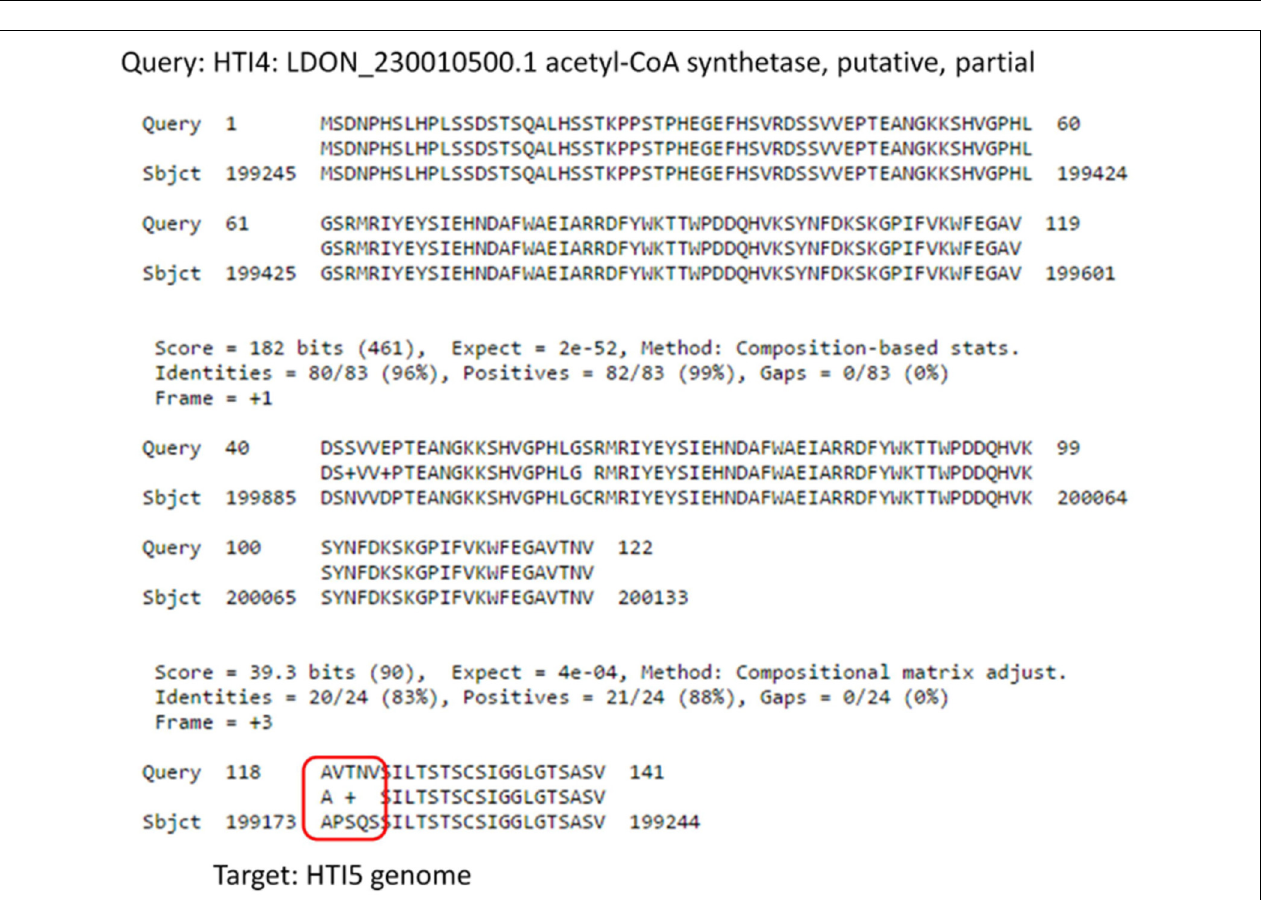
FIGURE 7 | Comparison of Acetyl Co-A synthetase genes in early and late passage. Gene coding for Acetyl CoA Synthetase undergoes several substitutions in the late passage which makes it non-functional.